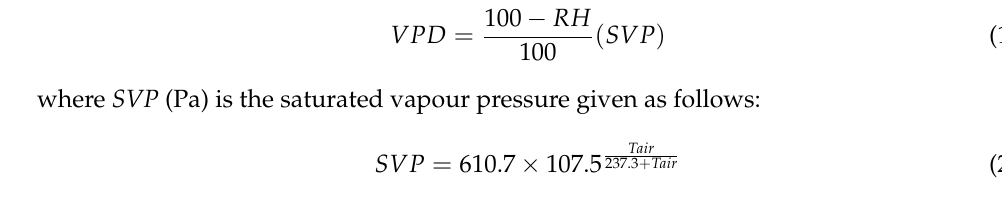
Table 2. Description of the eddy covariance systems at the investigated